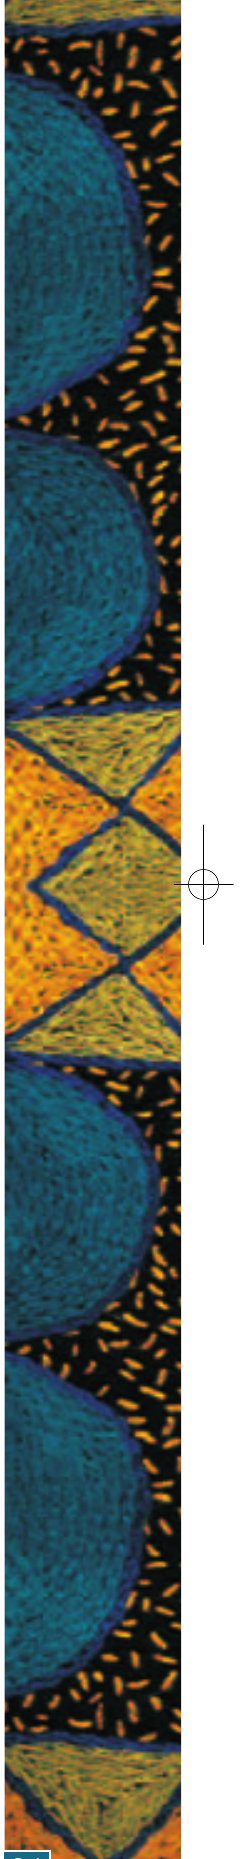
TABLE II. ARV AGENTS CURRENTLY AVAILABLE IN SOUTHERN AFRICA AND COMMON ADVERSE